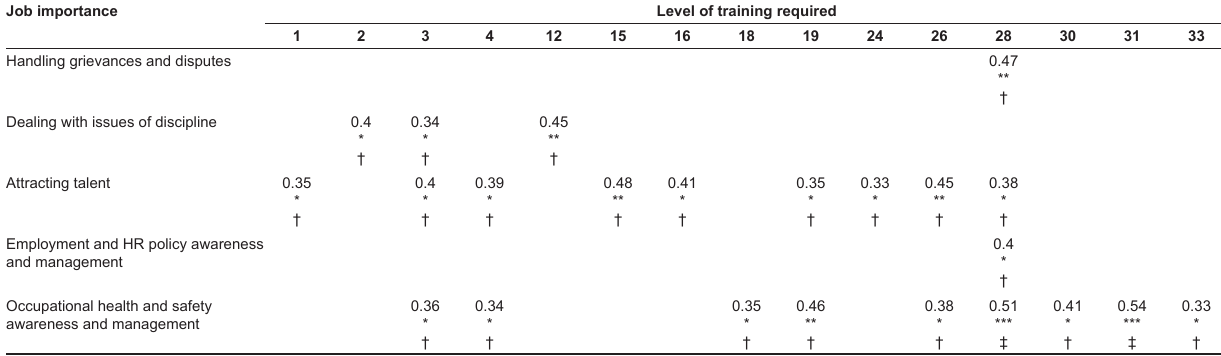
TABLE 5 Pearson product-moment correlations: Competencies relating to human resource specific